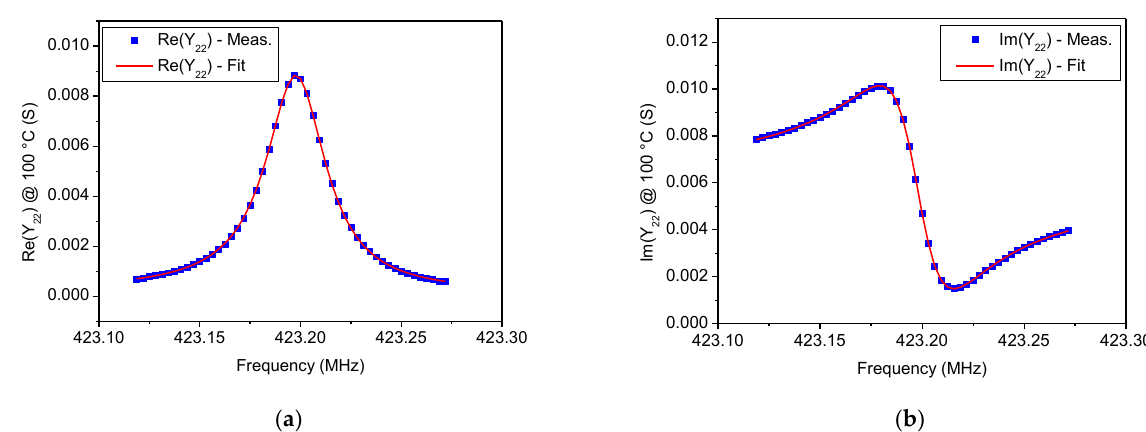
Figure 7. Comparison between measurements and Lorentzian fitting on the ( a ) Re( Y 22 ) and ( b ) Im( Y 22 ) for the tested SAW resonator at 100 °C.